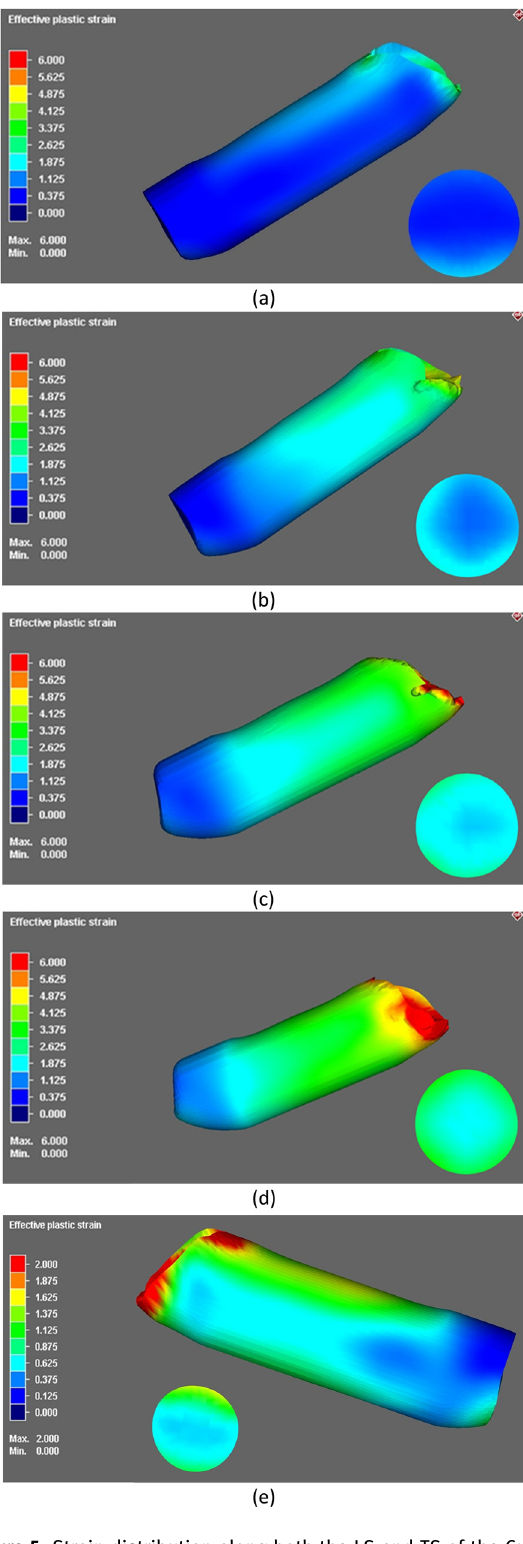
Figure 5: Strain distribution along both the LS and TS of the Cu billets processed through ECAP using the 90° - die through 1 - P (